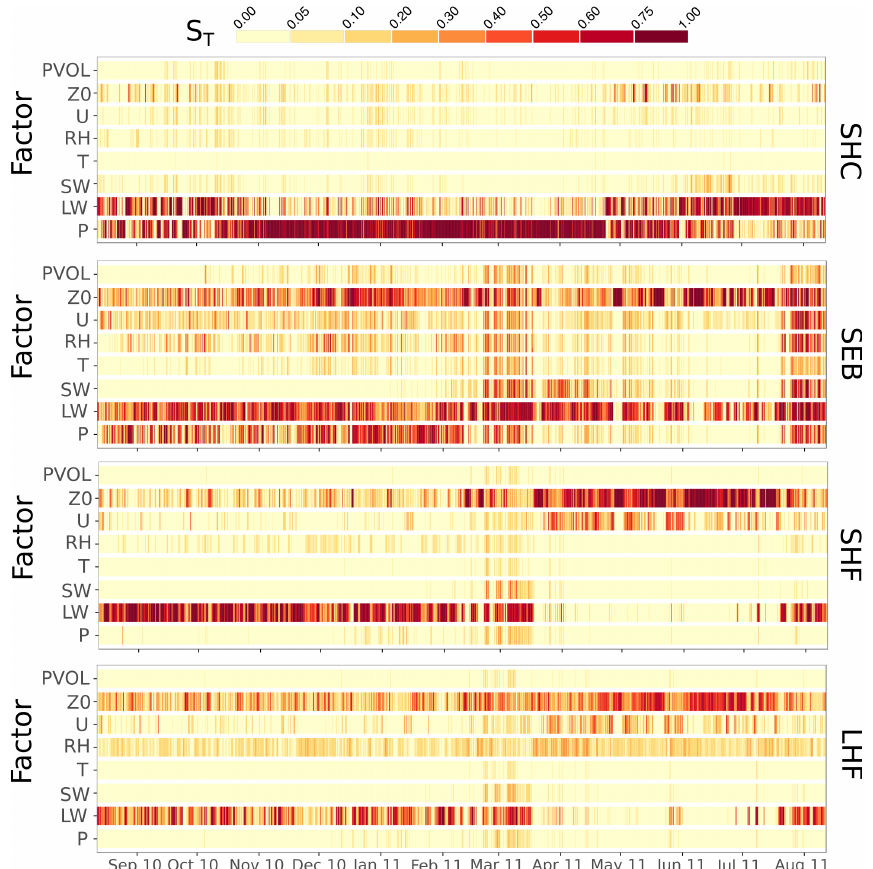
Figure 5. Evolution of the 6-hourly total-effect indices affecting modelled surface-height change (SHC), surface-energy balance (SEB), sensible heat flux (SHF) and latent heat flux (LHF) at KNG8. Refer to Table 2 for the explanation of the indicated uncertainty